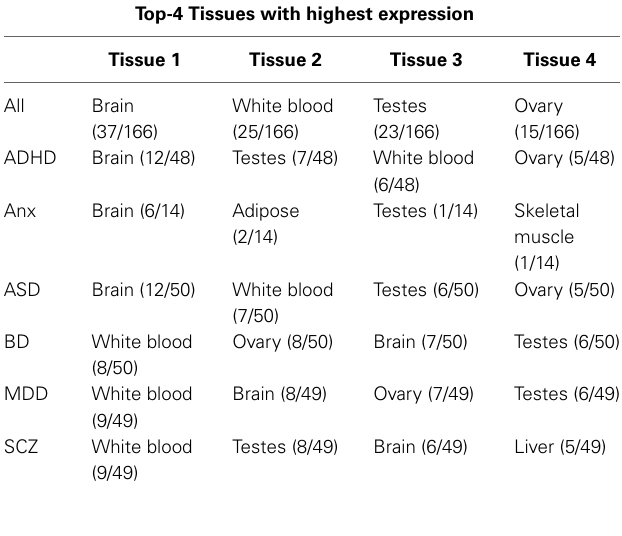
Table 1 | Top-4 tissues with highest expression for each disorder.